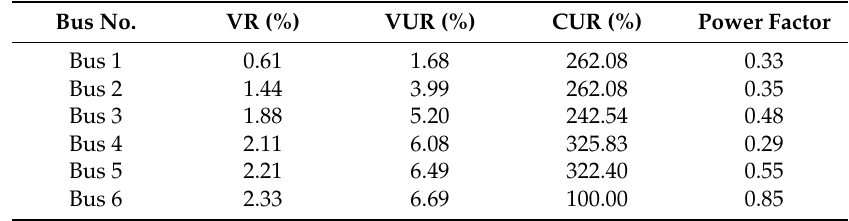
Figure 9. Power flow of Case 2. Table 3. Test result of Case 2.